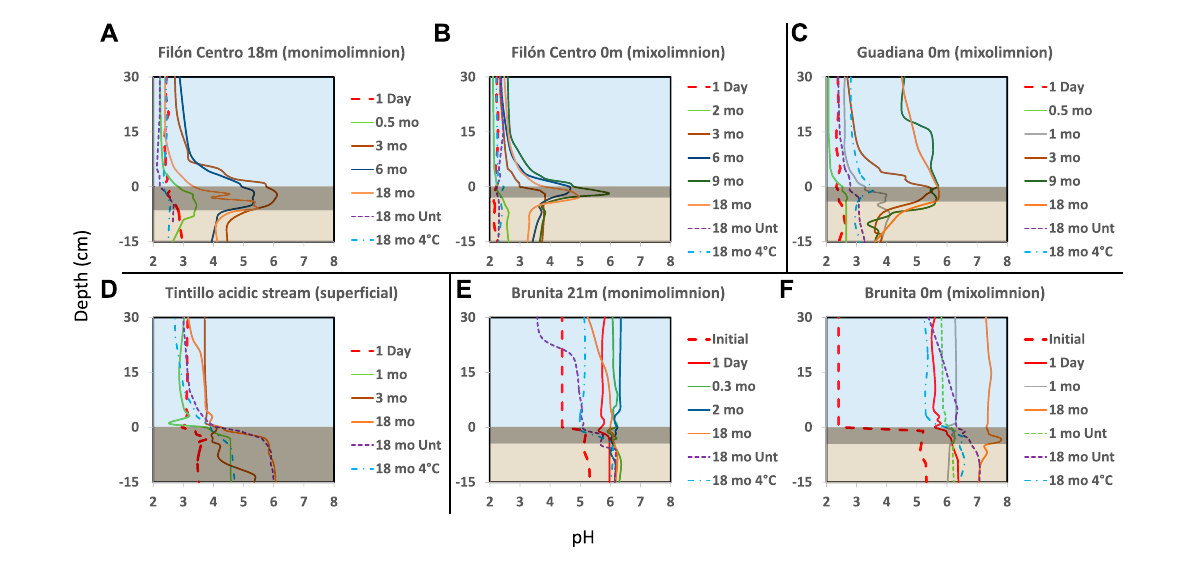
FIGURE 2 Depth pro fi les of pH ( x -axis) throughout the water and sediment ( y -axis represents depth) in the incubation columns built with sediments from the Filón Centro (A) monimolimnion (FC18) and (B) mixolimnion (FC0) (C) Guadiana mixolimnion (GU0) (D) Tintillo stream (TI) and (E) the Brunita pit lake monimolimnion (BR21) and (F) mixolimnion (BR0). Blue area shows the water column, dark rectangle represents black sediment (gly-amended column) and brownish the least affected sediment column. The line typerepresents thedifferent treatments: Dashed untreated; Solid: glycerol amended; Dash-dotted: cool-stored (incubated at 4 ° C). The thick red dashed line represents the initial pH at the beginning of the experiment. Zero depth is bound to the sediment-water